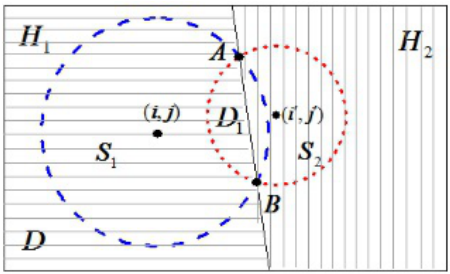
Algorithm 10: Distinguish Pseudo-point Algorithm